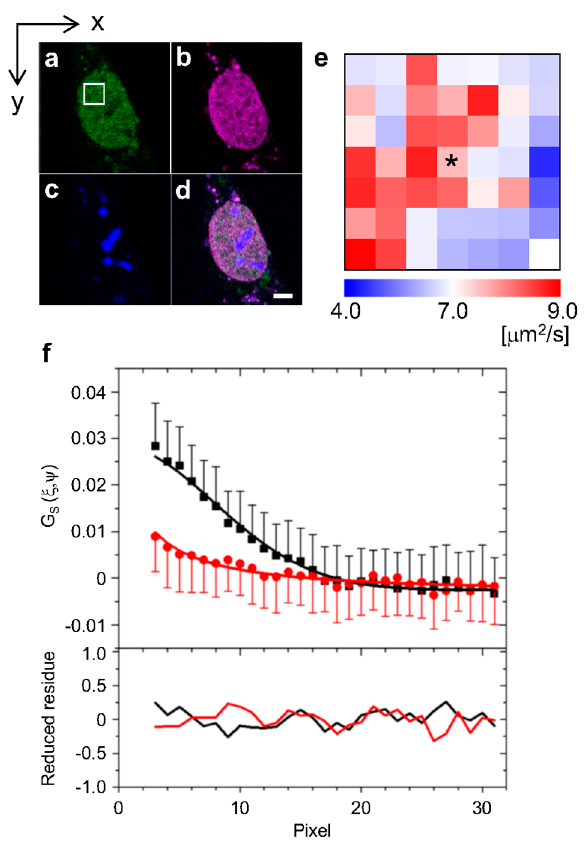
Figure 2. LSM image for RICS analysis. The LSM images are: ( a ) EGFP-hGR WT ; ( b ) H2B-mCherry; ( c ) TagBFP-fibrillarin; and ( d ) the merged image. The scale bar is 5 µ m. The white square in ( a ) indicates the region for RICS analysis, the size of which was 5.38 × 5.38 µ m. ( e ) The diffusion map with 7 × 7 bricks in the region represented the white square in ( a ) by RICS analysis. ( f ) The spatial correlation function and fitting (upper) and the reduced residue (lower) of the brick indicated with an asterisk (*) in ( e ). The black and red points indicate the spatial correlation function of x - and y -direction of images, respectively. Black and red lines indicate the fit by Equation (1).